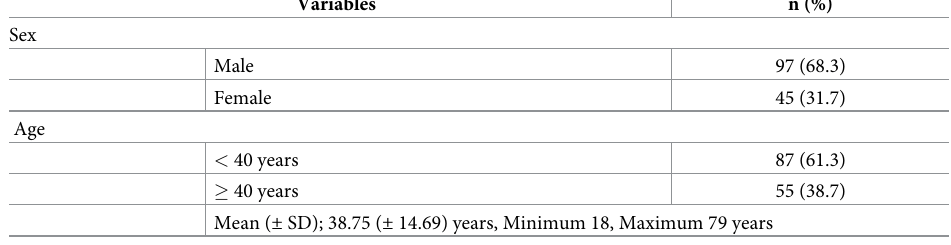
Table 1. Background characteristics of patients with